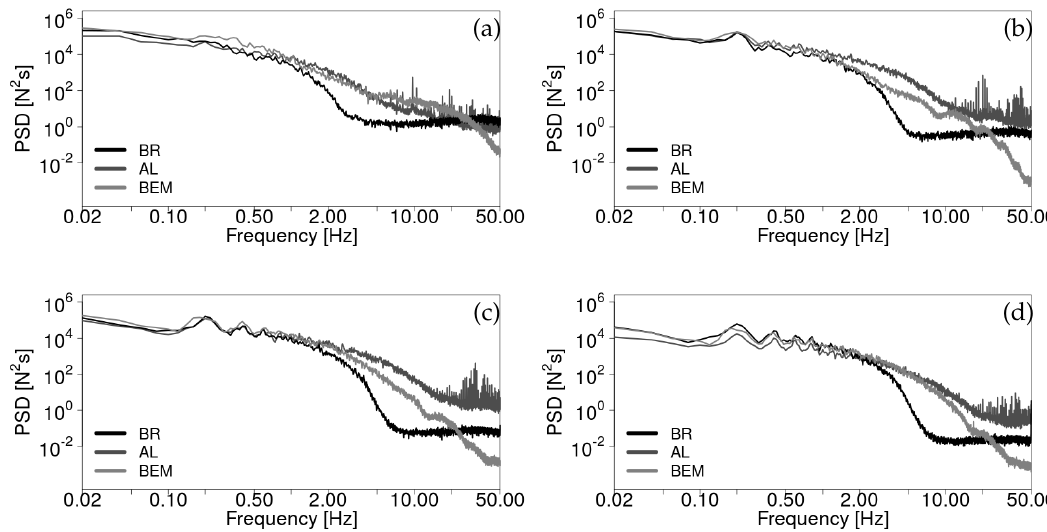
Figure 8. PSD of tangential forces at ( a ) 22.5%; ( b ) 50%; ( c ) 75% and ( d ) 95% radial